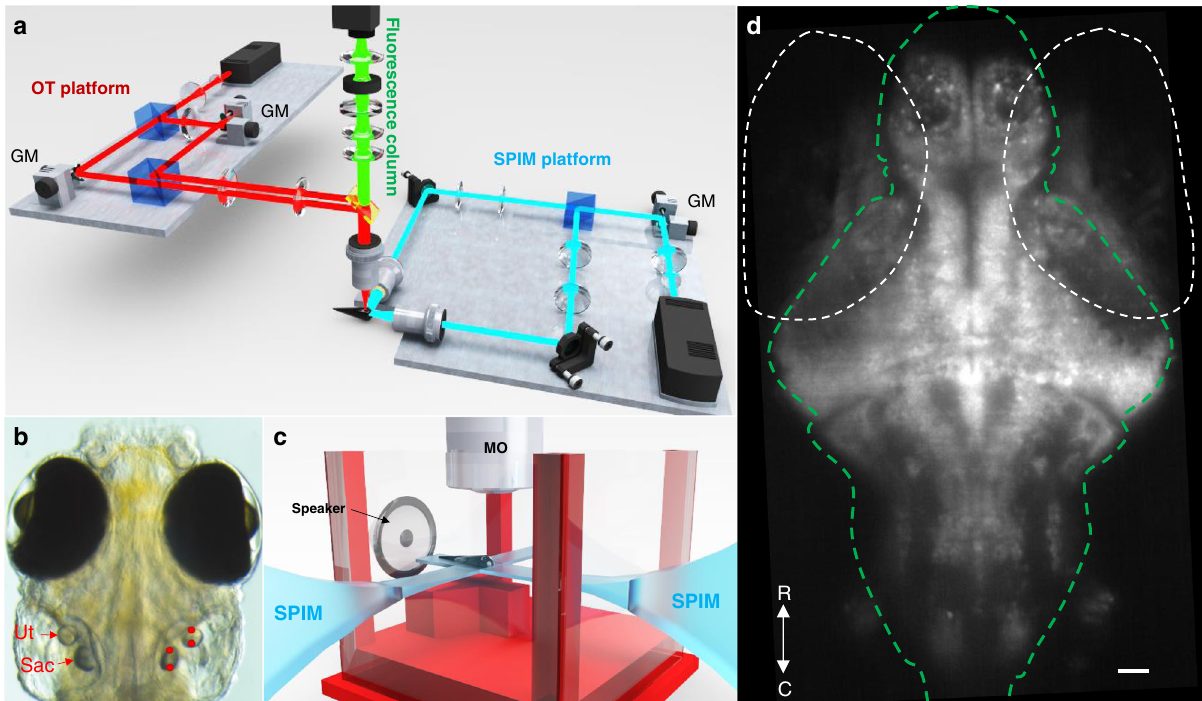
Fig. 1 Optical and sound stimulation of the auditory system in zebra fi sh. a Optical system comprising an OT platform for the generation of two optical traps, a SPIM platform for the illumination of a single plane of zebra fi sh brain, and a fl uorescence column for the imaging of GCaMP6s emissions. Details can be found in the “ Methods ” section. b OT (red dots, right) were placed at two locations within the utricular (Ut) and saccular (Sac) otoliths. The galvo mirrors (GM) on the OT platform displaced each trap from one location to the other at a frequency ranging from 1 Hz to 1 kHz. c Sketch representing the placement of a larva in a custom-built-chamber, the SPIM planes, the microscope objective (MO), and the location of the speaker. d Example of a fl uorescence image recorded from one plane in one fi sh. The white dashed ovals indicate the eyes, and the green line delineates the brain. R, rostral; C, caudal. Scale bar indicates 10 μ